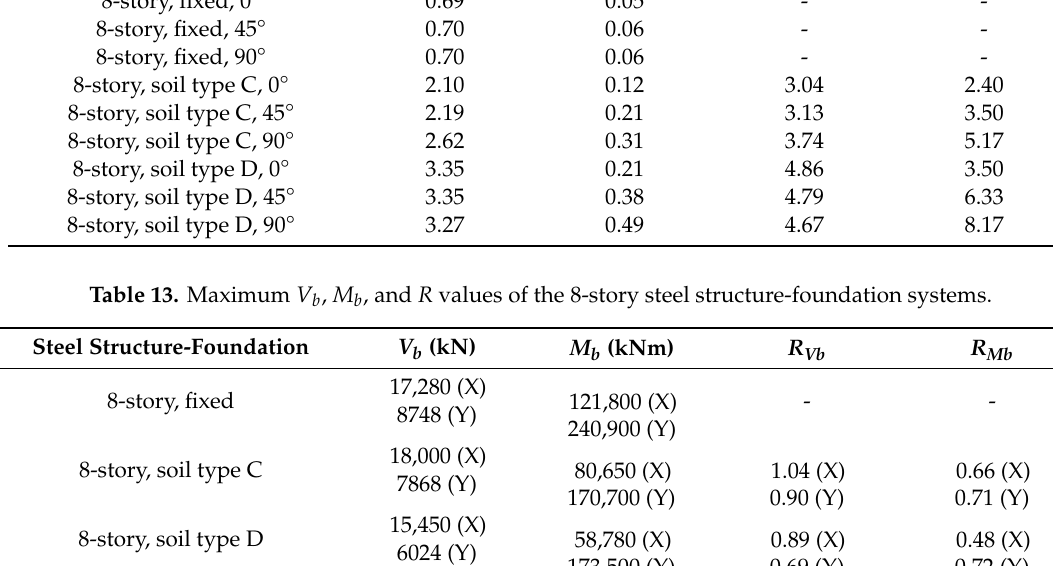
Table 12. Maximum IDR, RIDR, and R values of the 8-story steel structure-foundation systems. Steel Structure-Foundation, θ